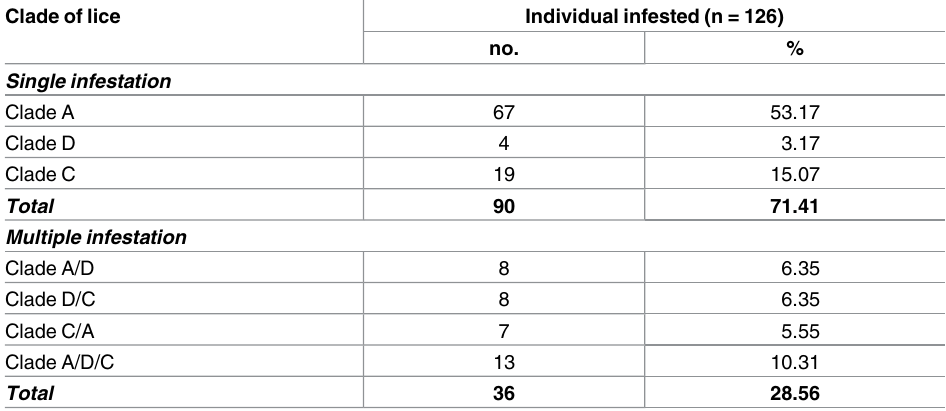
Ipendja and 34 sequences from Pokola villages) have the A17 haplotype, which is the second most common A-haplotype and derived from the A5-haplotype by one mutation step. The remaining five clade A sequences, four from Thanry-Ipendja and five from Pokola, defined three novel haplotypes, named here A57, A58, and A59. These three novel haplotypes derived from A17-haplotype by one mutation step. Haplogroup D, which is genetically close to A, only consists of haplotypes from Ethiopia and the Republic Democratic of Congo (RDC). The 45 (45/160) pygmy head lice sequences within clade D defined four haplotypes, of which three are novel (named here: D71, D72, D73), while the fourth haplotype possessed D65 haplotype from RDC. The clade C, representing the most divergent lineage in which two sub-clades can be defined, here referred to as sub-clade C1, which consists of head lice from Ethiopia, France and the Asian continent, and sub-clade C2, which consists of head lice from Senegal and Mali.